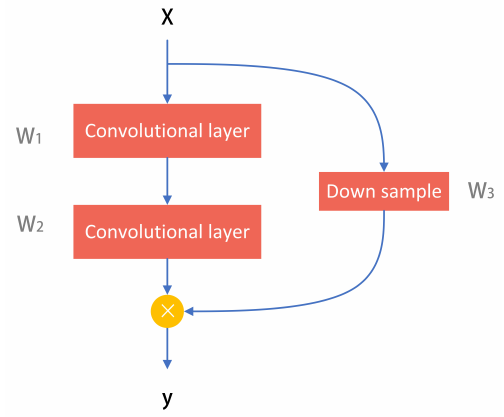
Figure 3. Residual learning